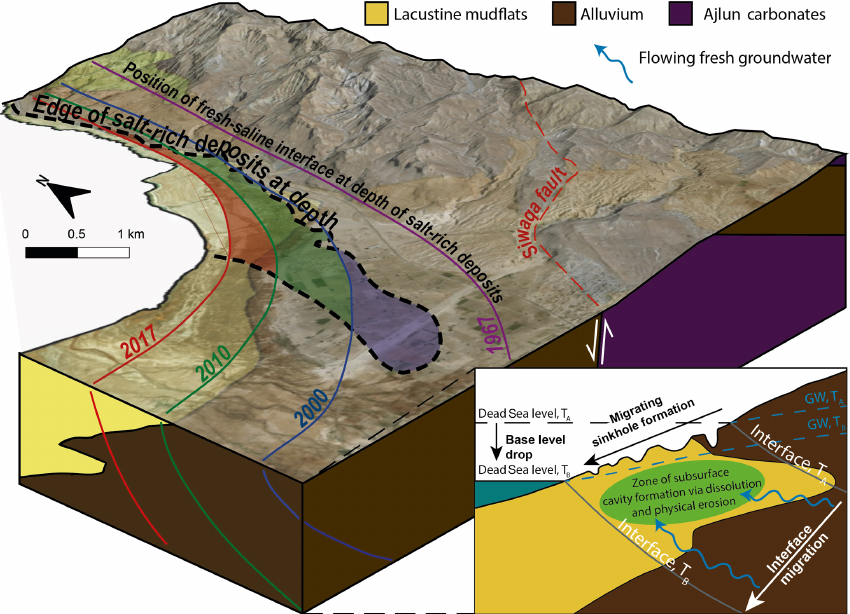
Figure 9. Hypothetical interaction of a migrating fresh–saline interface with subsurface salt-rich deposits. The shaded coloured areas depict the expected zones of sinkhole development for different time periods as a result of convergence between the salt-rich deposits at depth and the fresh–saline interface: blue represents 1985–2000; green represents 2000–2010; red represents 2010–2017. “Salt-rich deposits” here refers to deposits rich in numerous different evaporites. The inset shows the conceptual model of seaward migration of sinkhole populations at the Dead Sea as the fresh–saline interface migrates with the base-level drop, as outlined in Sect. 1, after Abelson et al. (2003, 2017), Yechieli (2000) and Salameh and El-Naser (2000). “GW” here refers to the inferred level of the groundwater in the